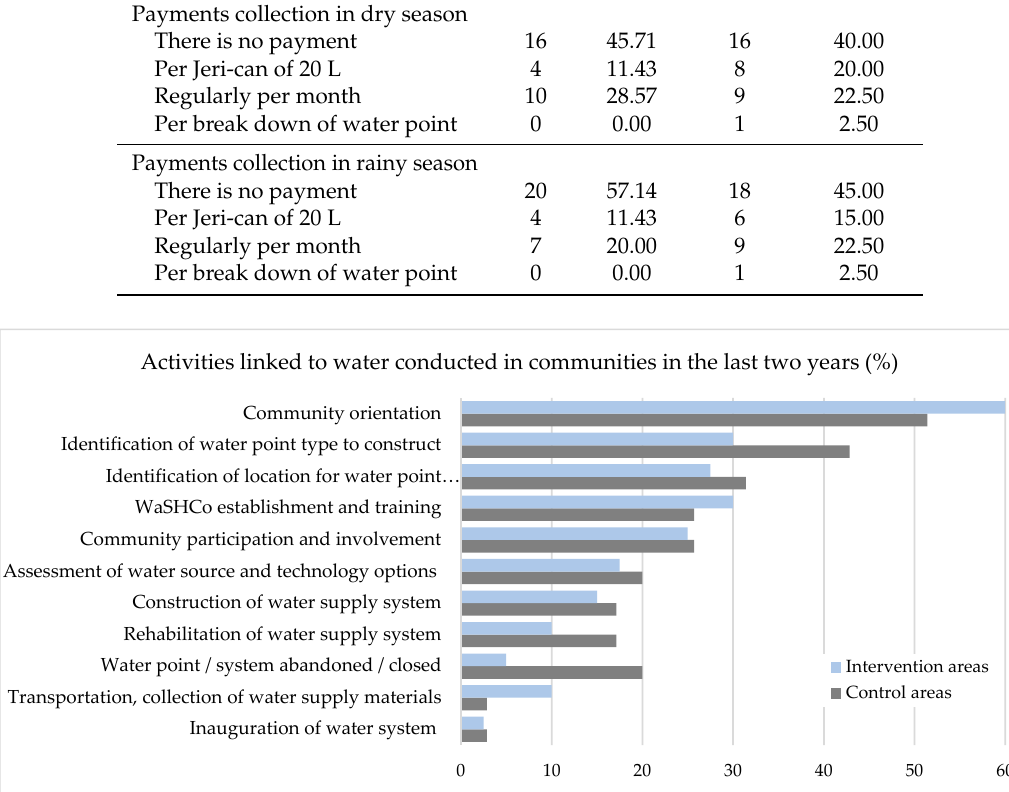
Table 7. Seasonal payment for water.